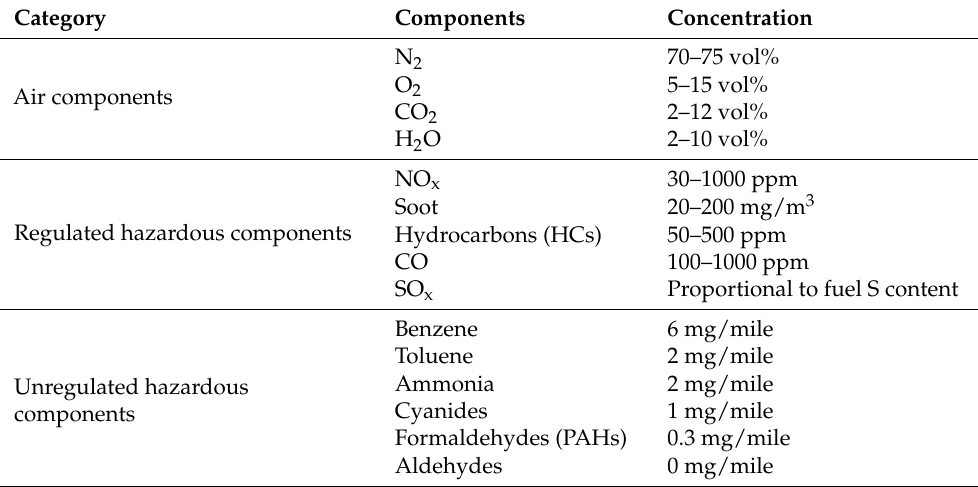
Table 1. Typical composition of diesel exhaust gas